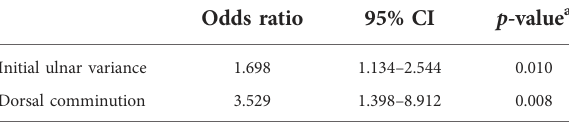
TABLE 4 Result of reduction loss-related factors from logistic regression